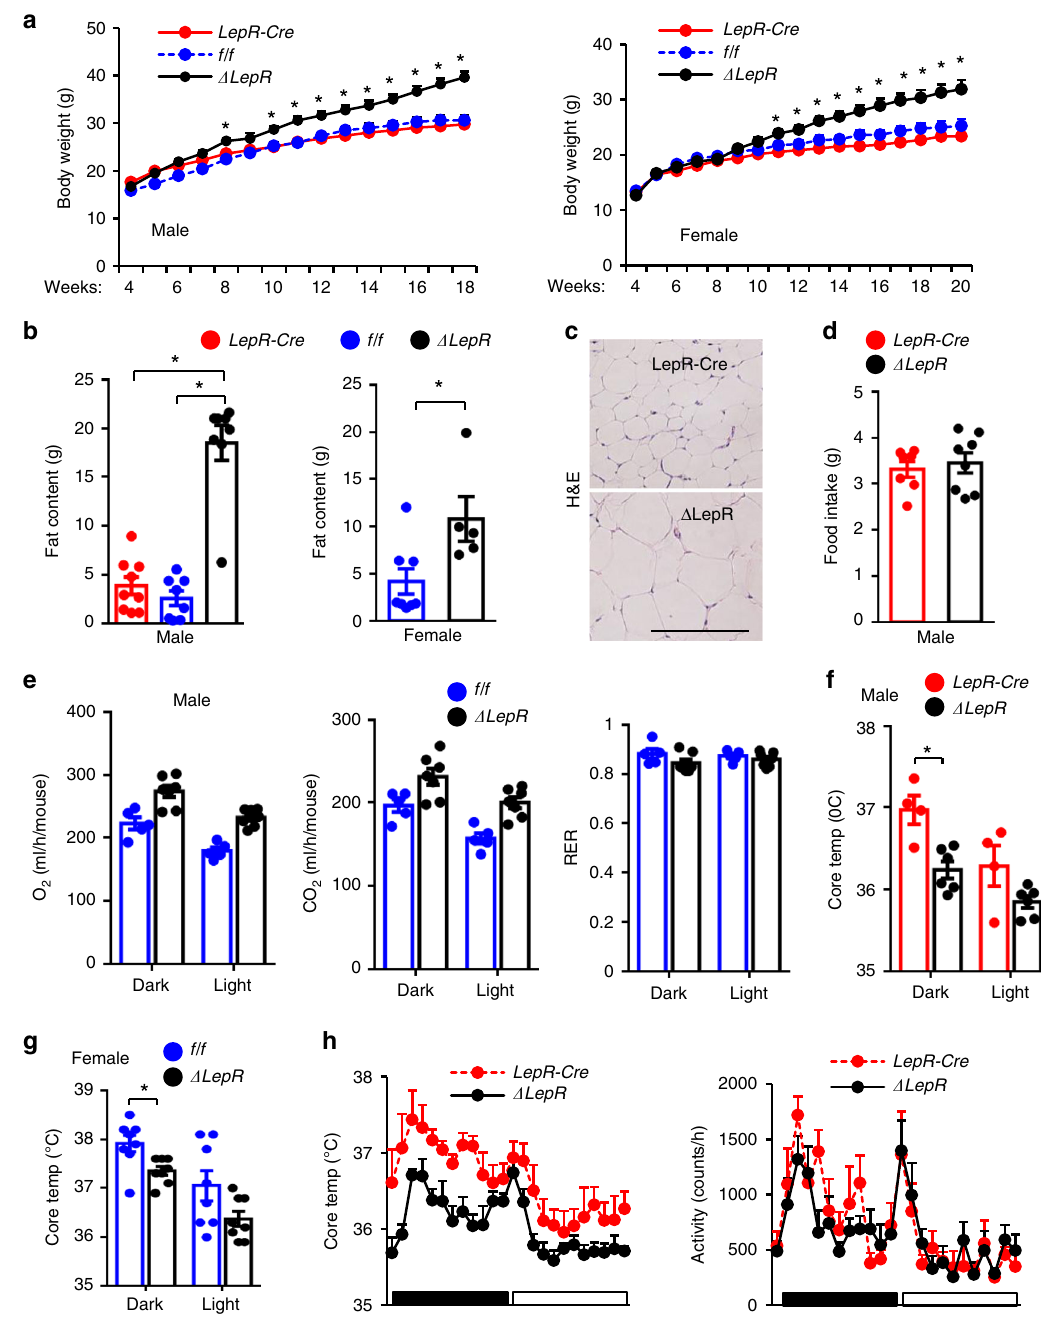
Fig. 1 Sh2b1 Δ LepR mice develop obesity. a Growth curves. Male: f/f : n = 10, LepR-Cre : n = 19, Sh2b1 Δ LepR : n = 25; female: f/f : n = 8, LepR-Cre : n = 15, Sh2b1 Δ LepR : n = 16. b Fat content. Male (22 weeks): f/f : n = 8, Cre : n = 9, Sh2b1 Δ LepR : n = 8; females (20 weeks): f/f : n = 8, Sh2b1 Δ LepR : n = 5. c Representative H&E staining of epididymal WAT sections at 22 weeks of age (3 pairs). Scale bar: 200 μ m. d Food intake of males at 10 weeks of age. LepR-Cre : n = 7, Sh2b1 Δ LepR : n = 8. e O f/f : n = 5, Sh2b1 Δ LepR : n = 7. f – g Rectal temperature at 2 consumption and CO 2 production at 10 weeks of age. Male: 20 weeks of age. Male: Cre : n = 4, Sh2b1 Δ LepR : n = 6; female: f/f : n = 8, Sh2b1 Δ LepR : n = 8. h Core body temperature and locomotor activity in male mice (10 weeks) recorded using pre-implanted E-Mitters. LepR-Cre : n = 4, Sh2b1 Δ LepR : n = 6. Data are presented as mean ± SEM. * p < 0.05, two-tailed unpaired Student ’ s t- test ( b female, d – g ), two-way ANOVA ( a ), or one-way ANOVA ( b male). Source data are provided as a Source Data fi